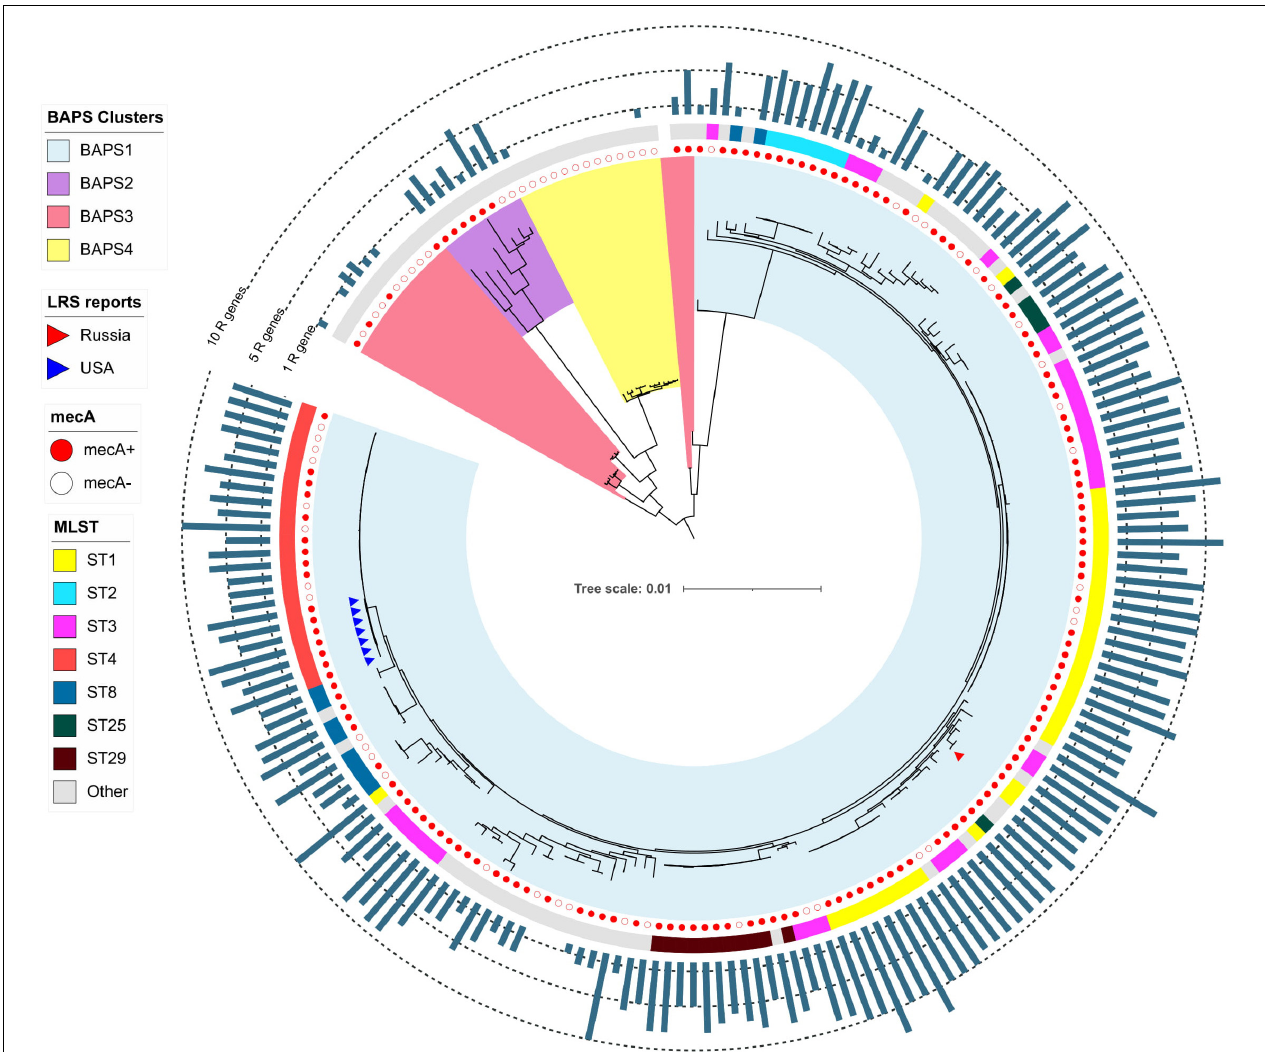
FIGURE 6 | Maximum-likelihood phylogeny of S. haemolyticus population ( n = 207) based on core-SNP alignment. Background color fill is matched to BAPS clustering (BAPS 1 to BAPS 4). Linezolid-restant isolates (LRS reports) isolates is marked triangles: from Russia (one isolate in current study) and the United States (Tewhey et al., 2014). Annotation from inner to outer circle: presence mecA ; MLST data; outer bar chart is matched to the number of acquired resistance genes (from 0 to 13 genes, specific chromosomal mutations were not included). The following genes were screened: aac(6 (cid:48) )-aph(2 (cid:48)(cid:48) ), aadD, ant(6)-Ia, ant(9)-Ia, aph(3 (cid:48) )-III, blaZ, cat, dfrG, ermA, ermC, cfr, fexA, fosB, fosD, fusB, fusC, lnu(A), lsa(B), mecA, mph(C), msr(A), str, tetC, tetK, tetL, tetM, vgaA, and vgaB.